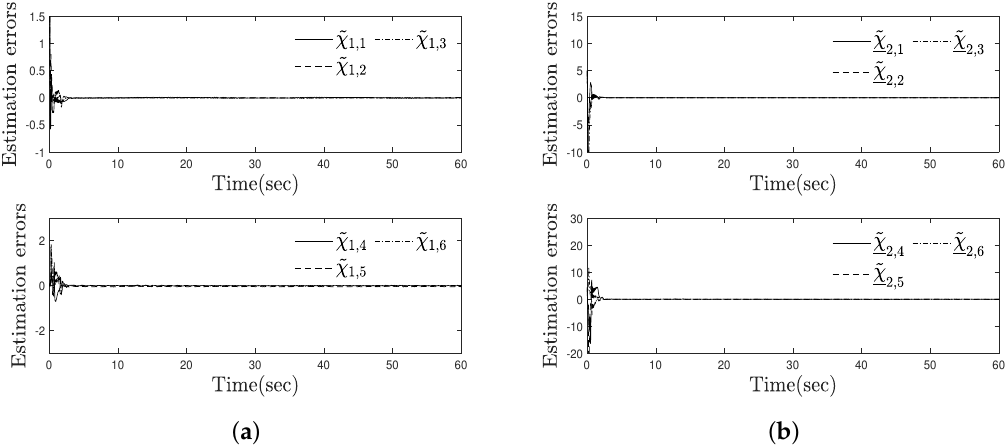
Figure 17. State estimation errors for Scenario 3 ( a ) ˜ χ 1,1 , ˜ χ 1,2 , ˜ χ 1,3 , ˜ χ 1,4 , ˜ χ 1,5 , and ˜ χ 1,6 ( b ) ˜ χ